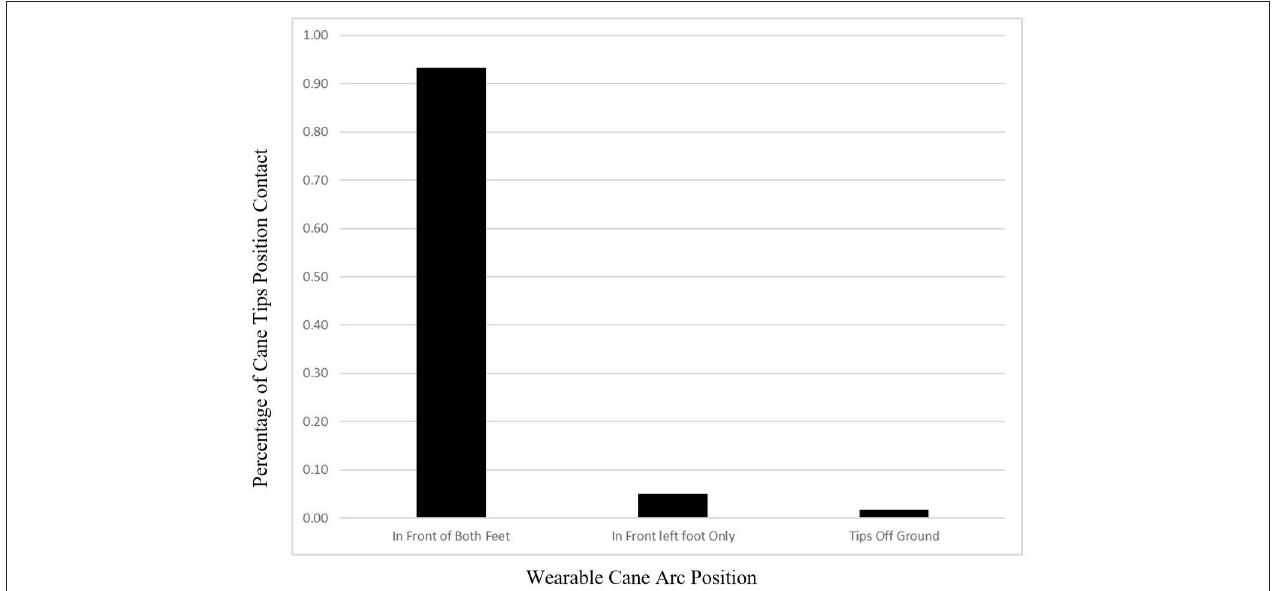
FIGURE 4 | Autonomous cane arc positioned cane tips two-step ahead fo both feet 93% of the time ( N = 1,920 steps).